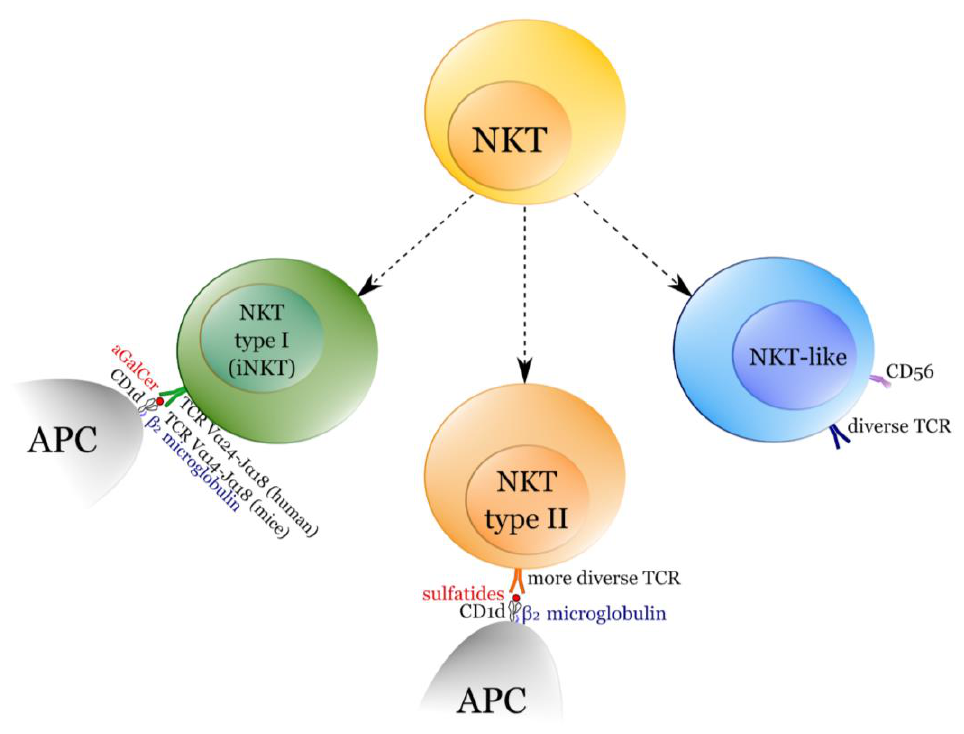
Figure 1. Main populations of NKT cells—type I (invariant NKT, iNKT), type II, and NKT-like. APC—antigen-presenting cell, NKT—natural killer T cell.